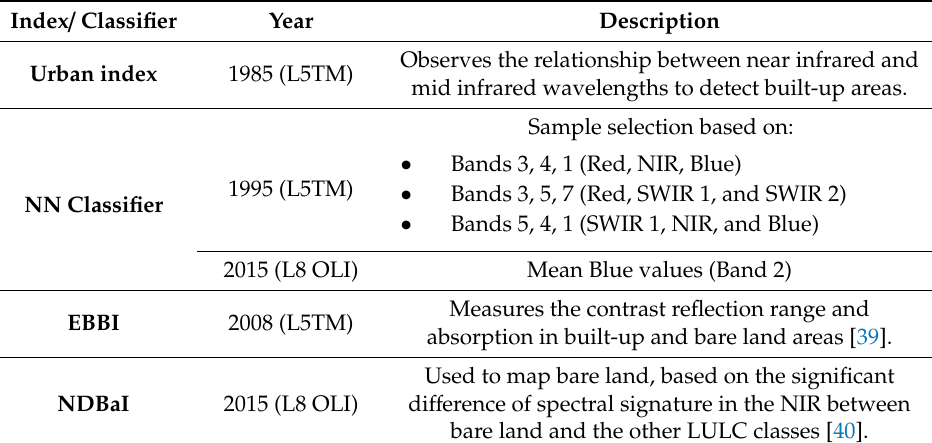
Table 3. Di ff erent index applied for delineation of bare land and built-up area